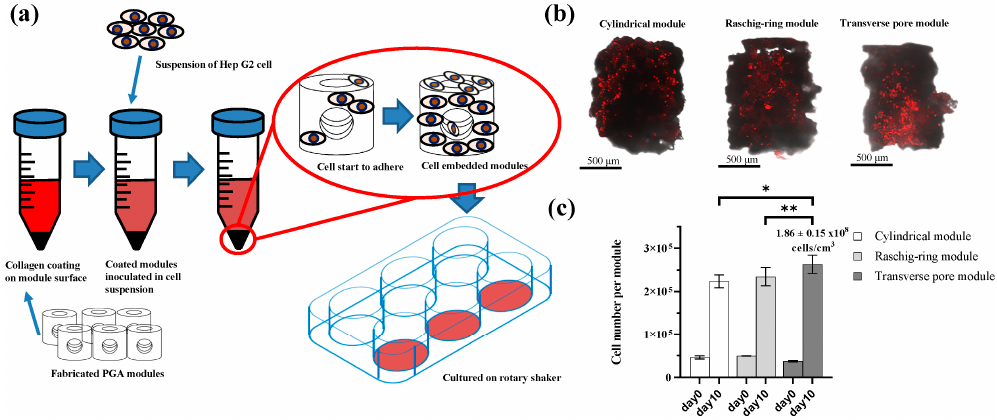
Figure 3. ( a ) Schematic illustration of cell inoculation. ( b ) Confocal images of immobilized human hematoma Hep G2 cells on Day 2 after inoculation. ( c ) Comparison of cell growth between different module types. Each point represents mean ± SD (n = 2, independent experiments), * P < 0.05, ** P < 0.01.